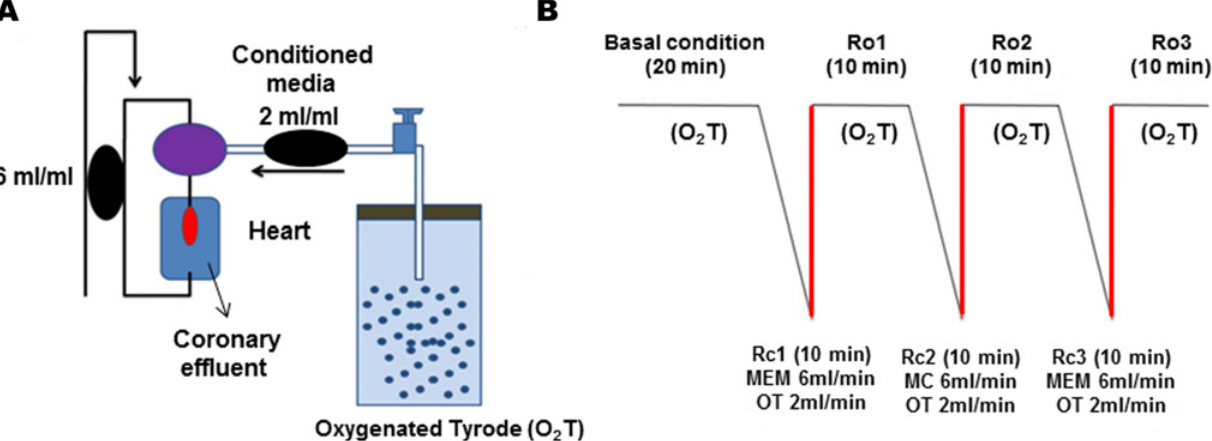
Fig 1. (A) Perfusion circuit with recirculation/ reoxygenation. The black ovals represent the two peristaltic pumps used to perfuse solutions. The magenta oval represents the device on which the cannula is inserted to perfuse the heart and red oval represents the heart. The black lines show the connections that allow the entry of oxygenated solution (O 2 T) in the heart. (B) Protocol of recirculation/reoxygenation. Rc: Recirculation and Ro: Reoxygenation. The red and diagonal black lines indicate the parallel perfused Conditioned medium or